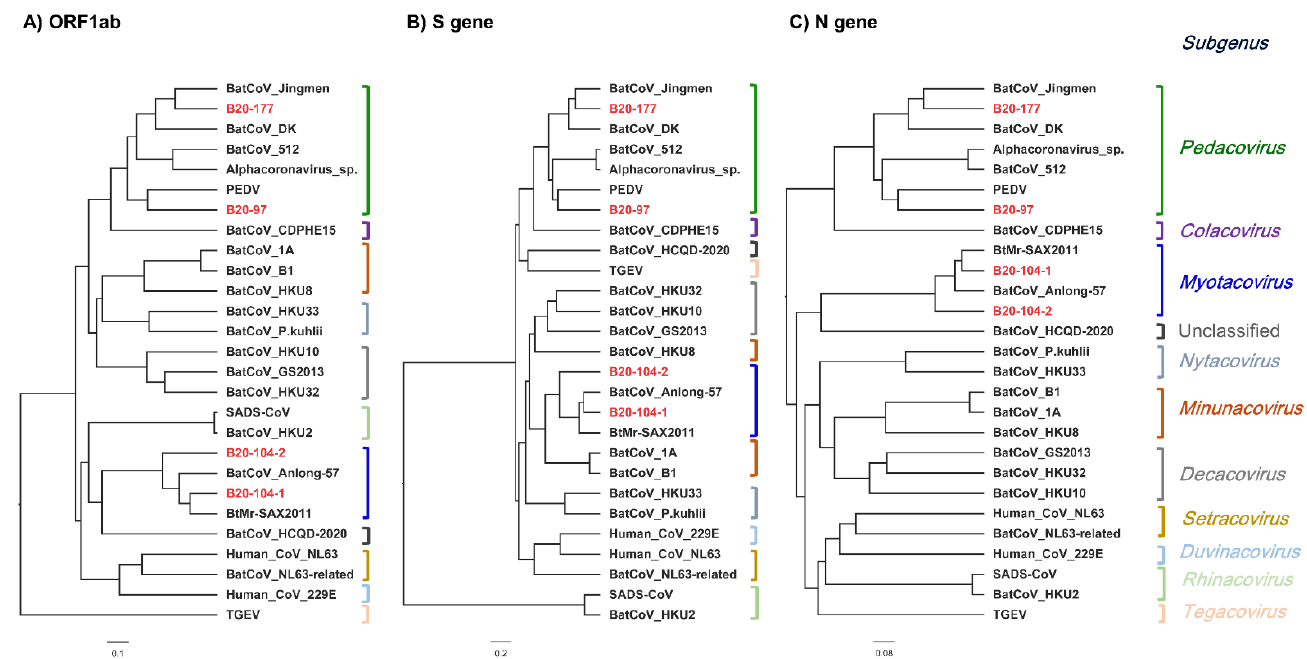
Figure 4. Maximum clade credibility (MCC) tree estimated by Bayesian Evolutionary Analysis Sampling Trees (BEAST) of full ORF gene from the complete genome sequences with reference sequence from αCoVs. Sequence names are provided in taxon labels. Strains identified in this study are colored in red. The ( A – C ) trees are based on ORF1ab, S, and N gene, respectively. The scales represent evolutionary distance. Statistical support (posterior probability) of all nodes was greater in value than 0.99.